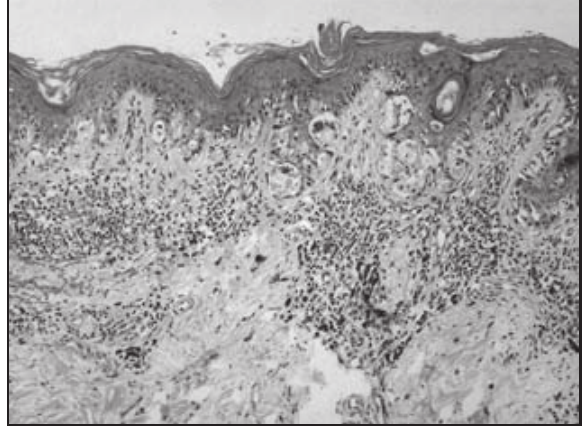
Figura 2 – Área de regressão intermediária em um melanoma in situ . Moderado infiltrado inflamatório, discreta fibrose na derme papilar, melanófagos e proliferação vascular. Caso 1, HE, 100x (aumento original) HE: hematoxilina e eosina.